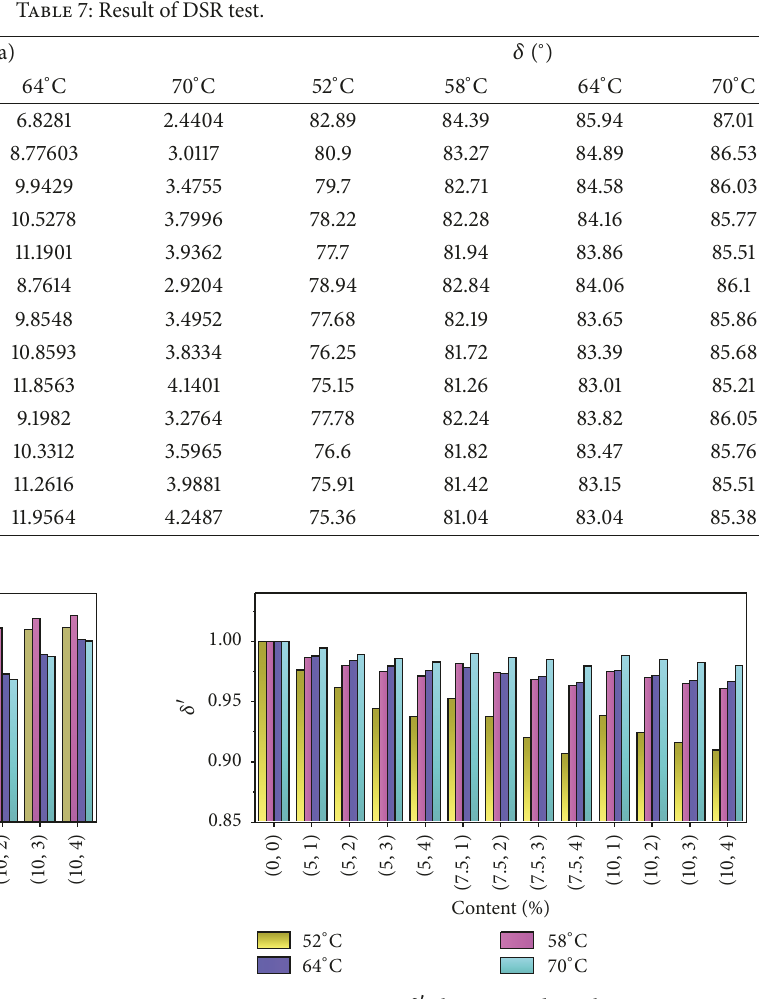
Figure 3: 𝐺 ∗󸀠 change trend graph. Figure 4: